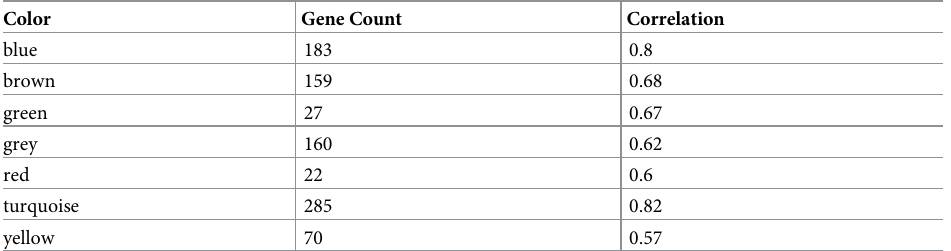
Table 2. The correlation between the traits values of each module and the disease